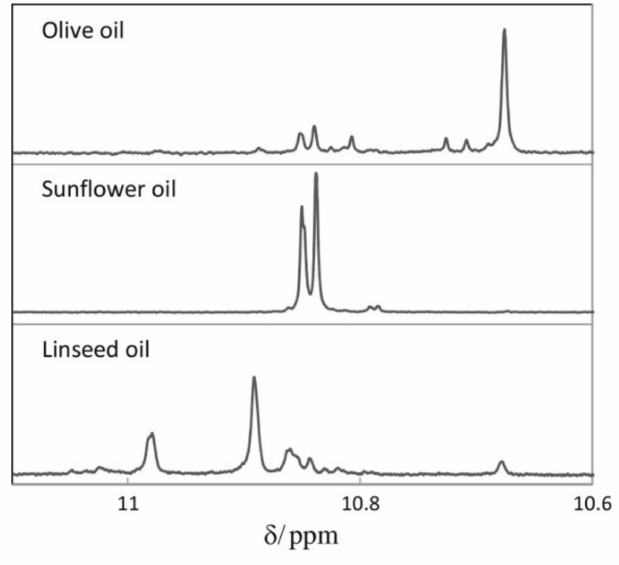
Figure 28. Hydroperoxide-proton region (10.1–11.0 ppm) of oils with high content in oleic (olive oil), linoleic (sunflower oil), and linolenic acid (linseed oil). Reprinted with permission from [130]. Copyright 2012, AOCS.